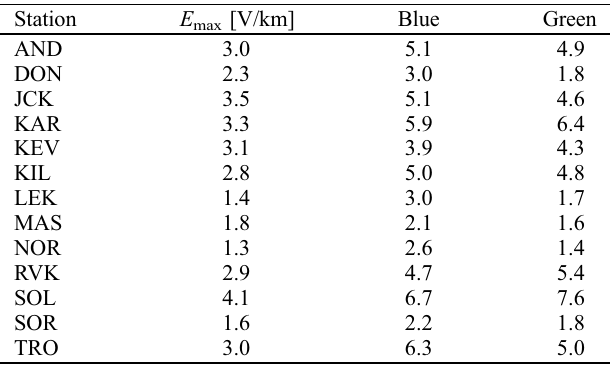
Table 4. The largest modelled 10-s value of the horizontal electric field ( E max ) in 1994–2011 at selected IMAGE magnetometre stations, and the extrapolated maximum value occurring once in 100 years, as obtained by two different methods. The full conductivity model has been used. Station E max [V/km] Blue Green